Question: Which kind of chart has been used to present this data?
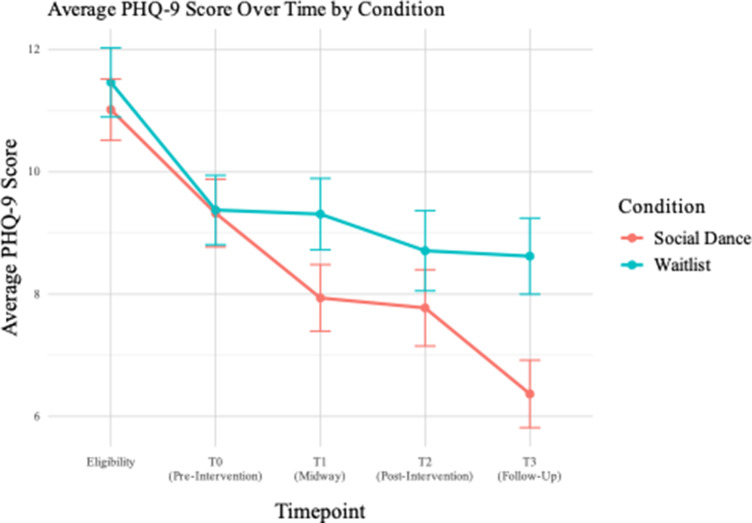
Answer: line